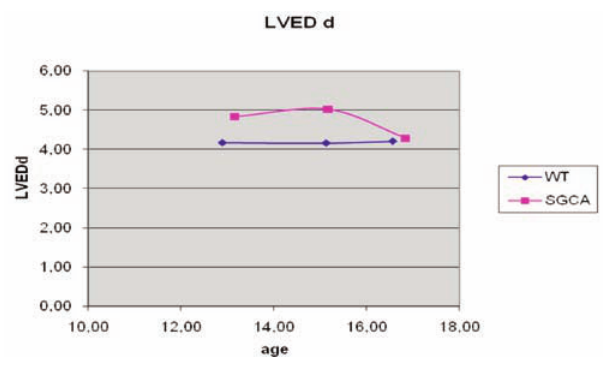
Figure 3. Evolution of the LV end-diastolic diameter (LVED d) from age 13 months to 17 months in sgca-null mice and WT mice. LVED d (unit) = mm, Age =